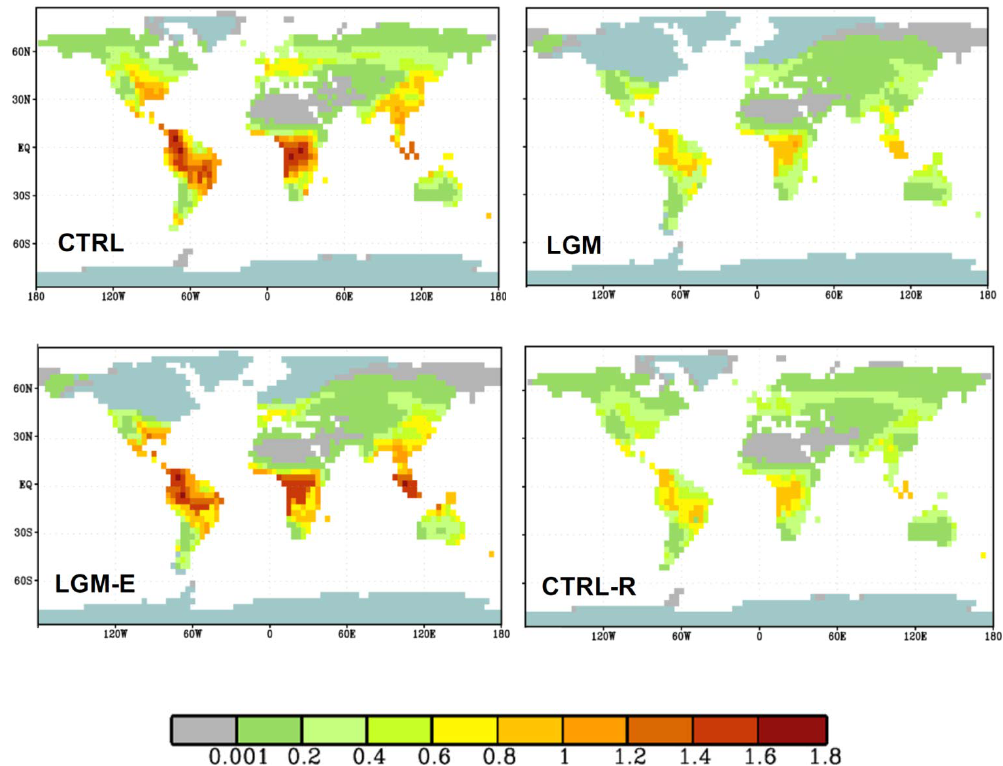
Fig. 8. Net primary production (NPP) (in kgm − 2 yr − 1 ) for different simulations of pre-industrial climate (CRTL), climate of the Last Glacial Maximum (LGM), climate of the Last Glacial Maximum, but with physiologically effective CO 2 of 280ppm as in pre-industrial climate (LGM-E), and pre-industrial climate, but with physiologically effective CO 2 of 185ppm as in glacial climate